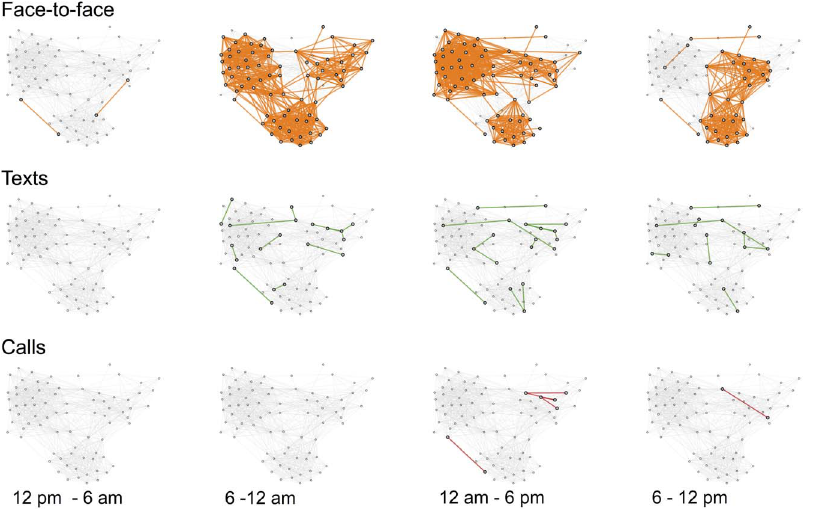
Figure 11. Daily activations in three networks. One day (Friday) in a network showing how different views are produced by observing different channels.